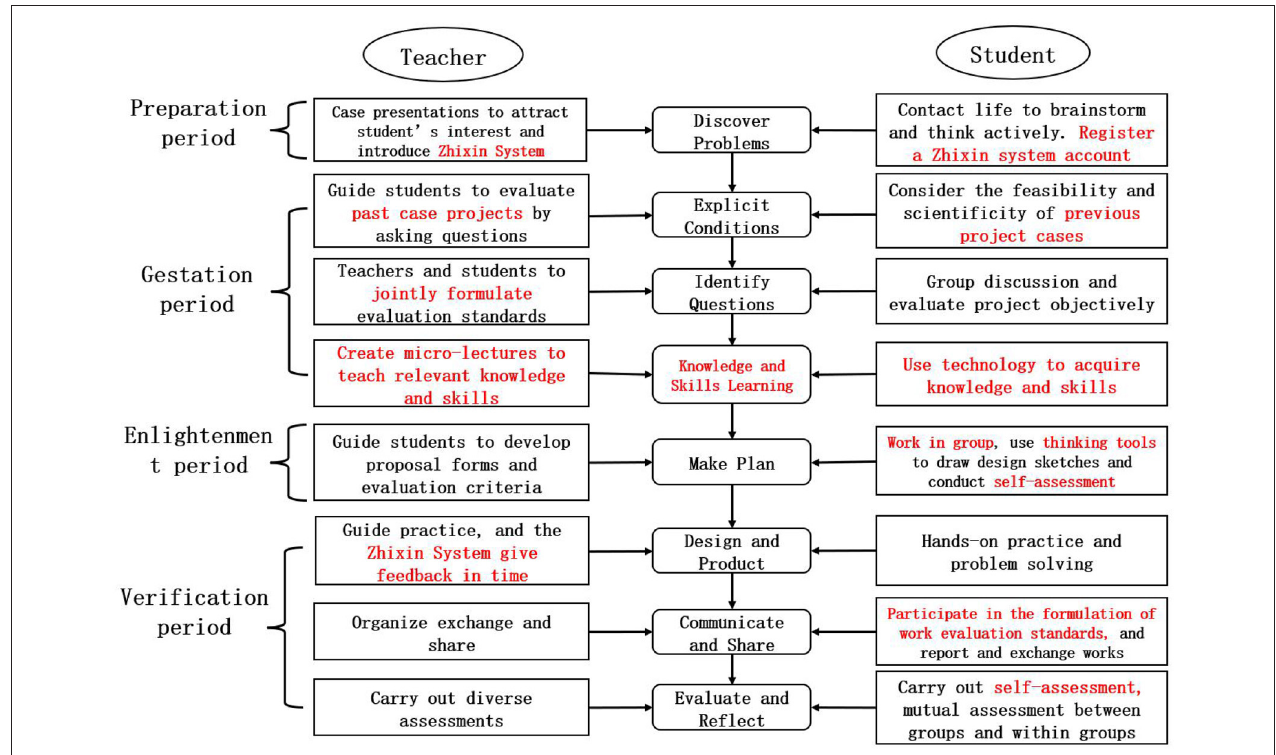
FIGURE 2 | General technology course teaching model based on the concept of maker education (after action